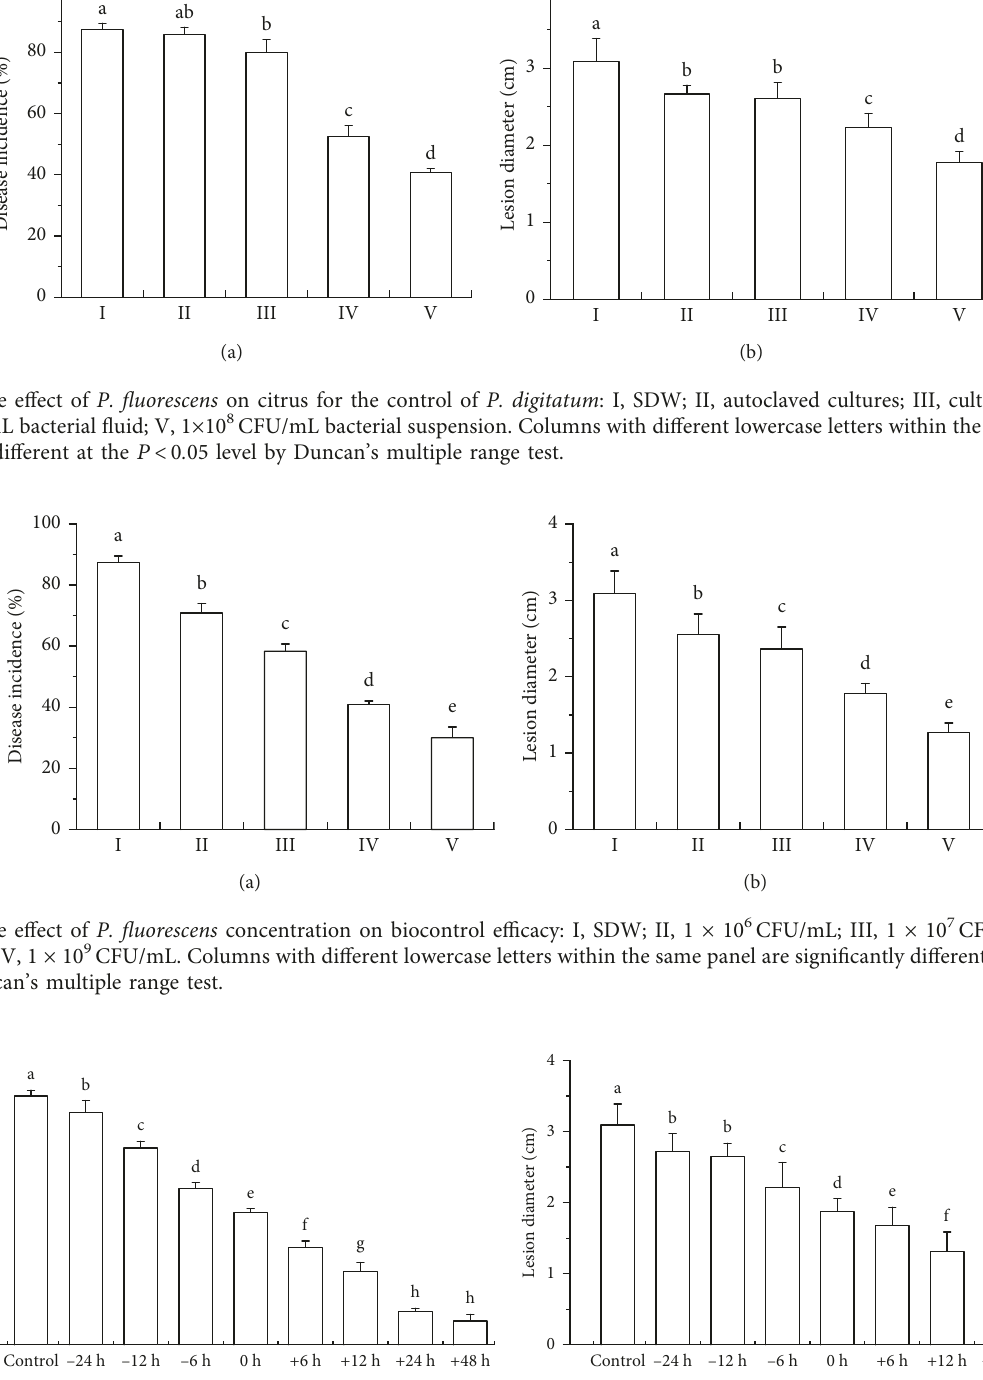
, citrus were inoculated P. digitatum prior to P. −